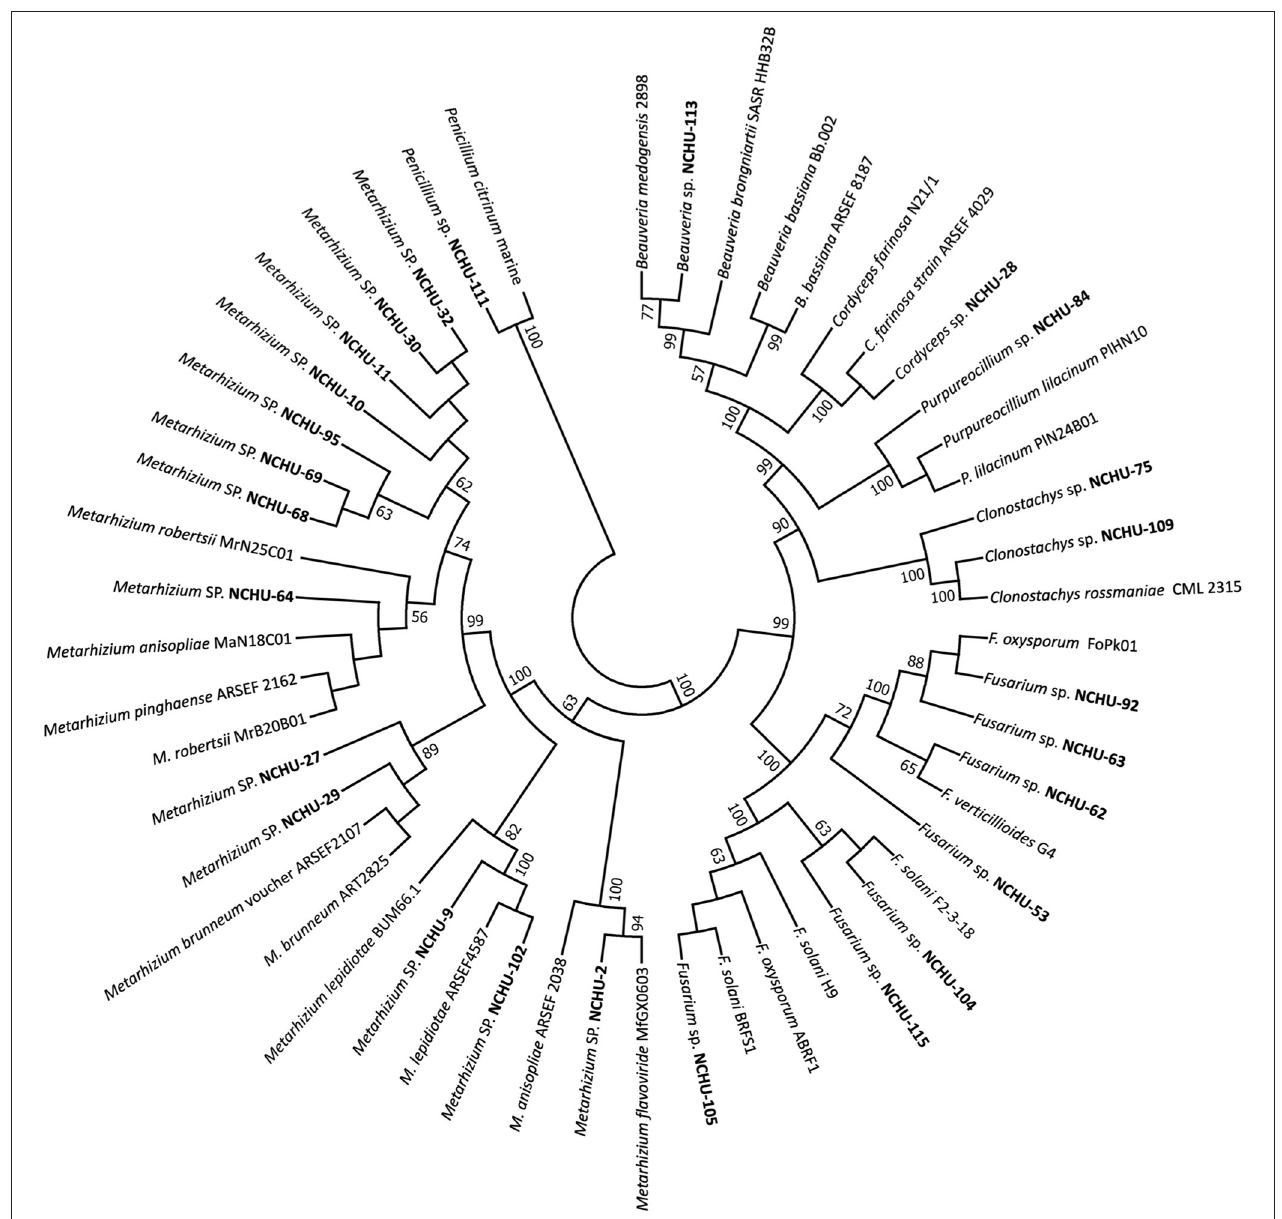
FIGURE 3 | A phylogenetic tree was constructed by using the neighbor-joining (NJ) method based on the fungal ITS for 26 potential entomopathogenic fungal isolates in MEGA7. Bootstrap analyses were performed to evaluate the robustness of the phylogenies using 1000 replicates.